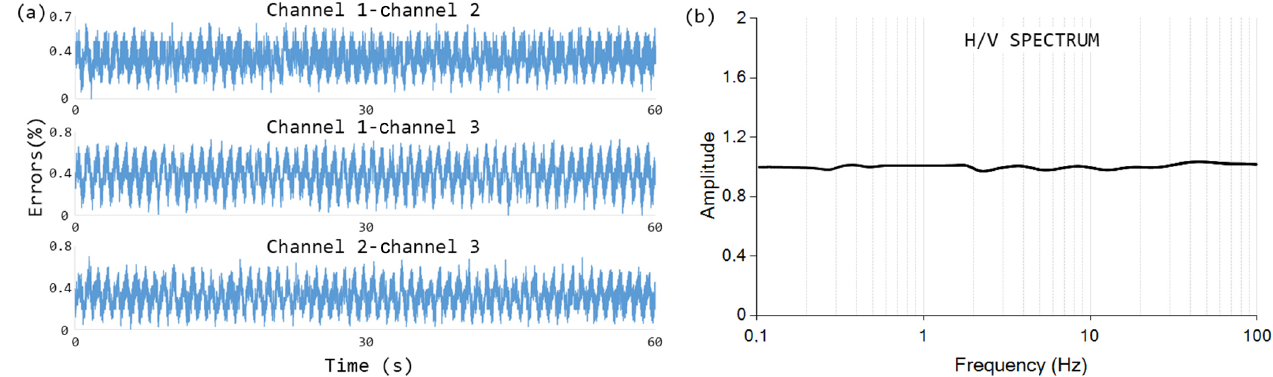
Figure 4. (a) Error percentage of difference signal estimated during the first channel consistency test; (b) H / V spectral ratio.